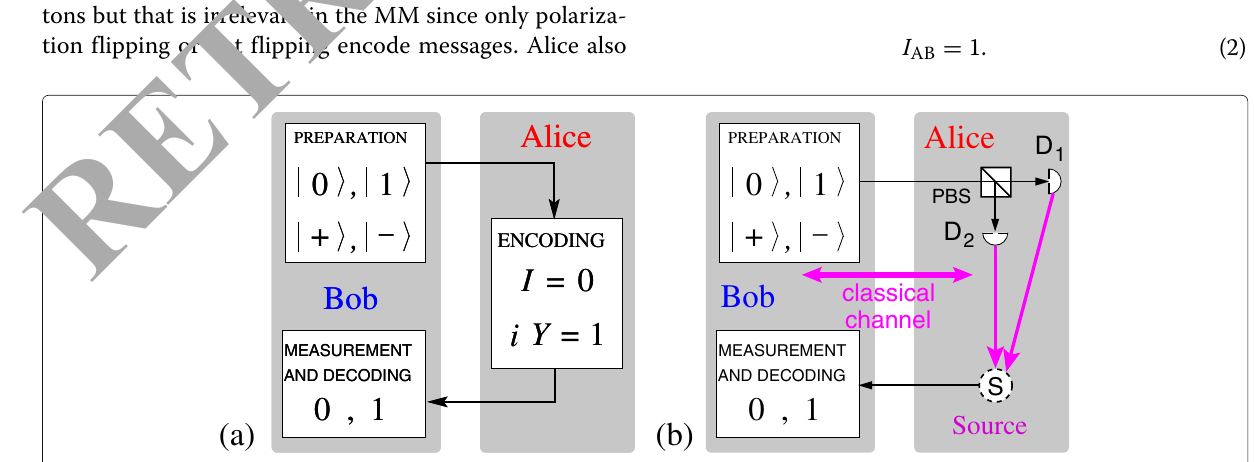
Fig. 3 LM05 protocol. a Message mode (MM) according to [19, Fig. 1]. b Control